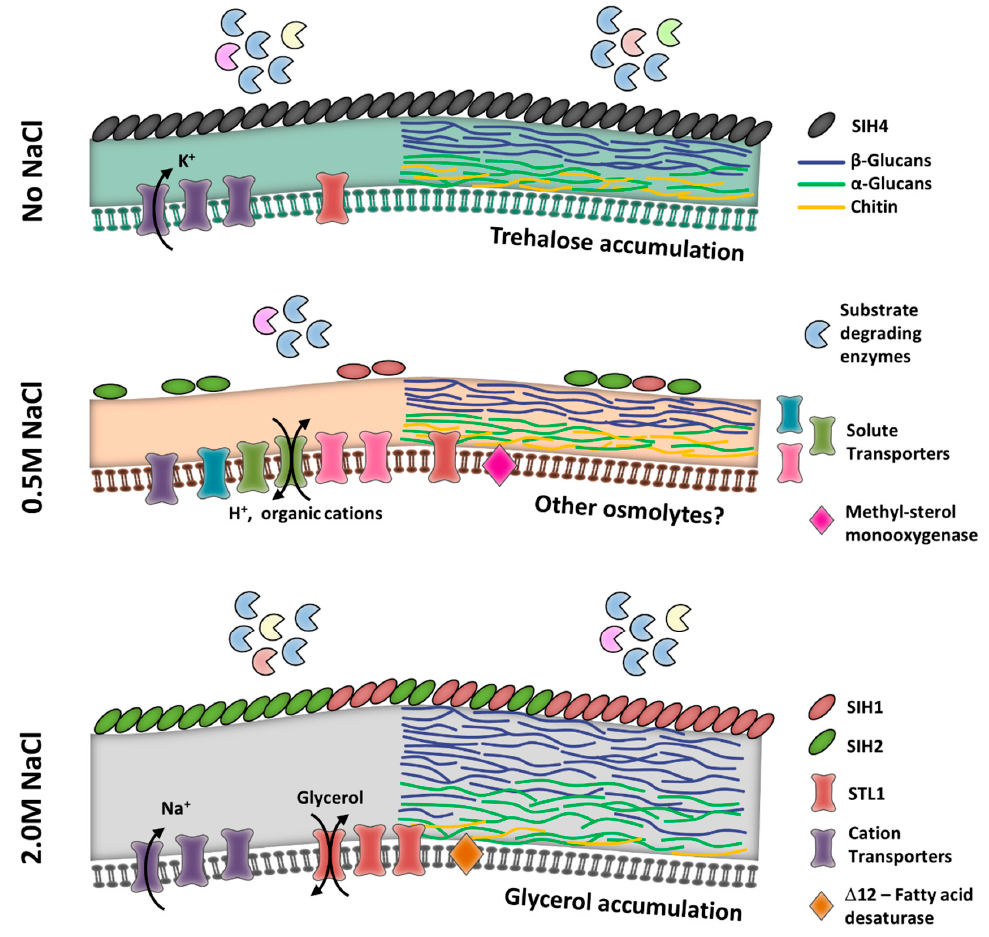
Figure 5. Proposed mechanisms of tolerance to salinity and hyperosmotic stress in Aspergillus sydowii . The location of SIH hydrophobins at the cell wall is putative. Cell wall composition was inferred from the expression of genes involved in the synthesis of polymers.